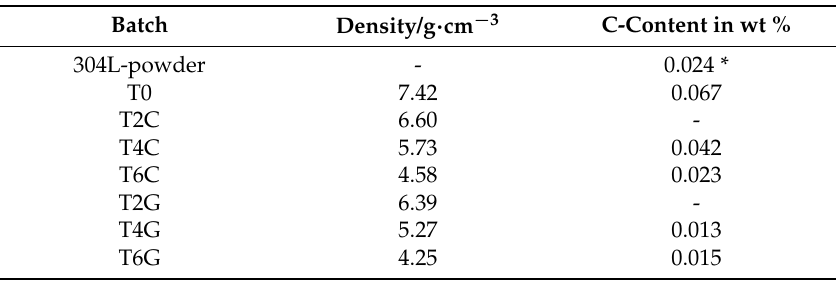
Table 3. Results of the density measurements and of the chemical analysis of the raw metal powder and the sintered test